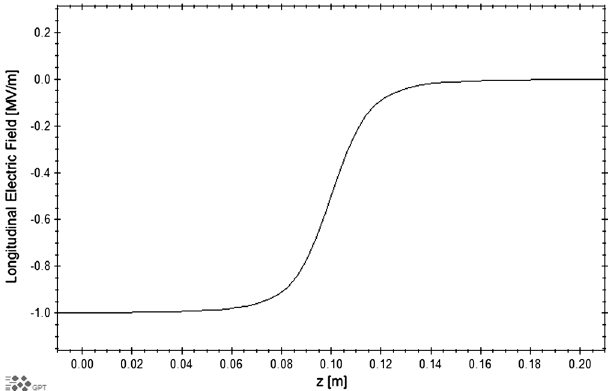
FIG. 3. On-axis longitudinal field profile as a function of distance from the cathode of the simulated electron